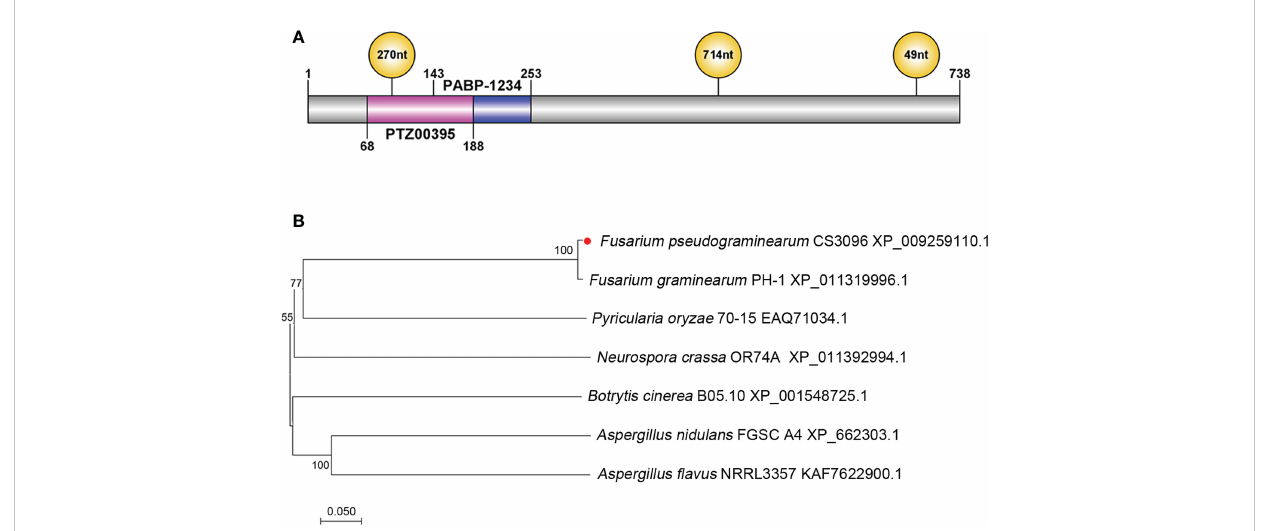
FIGURE 1 Structures and phylogenetic analysis of LaeB /LaeB of Fusarium pseudograminearum . (A) Location of conserved domains and intron in the FpLaeB protein and gene, respectively. Blue and pink bars represent polyadenylate binding protein domain (PABP-1234) and Sec24-related protein domain (PTZ00395), respectively. Three introns interrupted the FpLaeB gene at different positions. (B) Phylogenetic analysis of LaeB in F . pseudograminearum and other fungi. The neighbour-joining method used to analyse the amino acid sequences by the MEGA version 7.02 software package. The numbers at branches represent the supporting percentage of 1,000 bootstrap replicates.